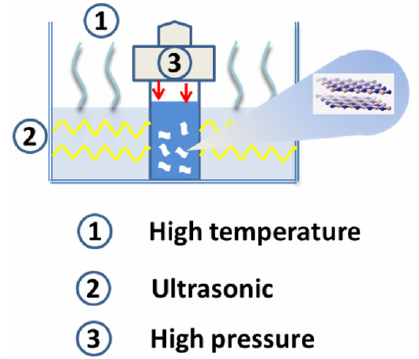
Fig. 1 Schematic of sonication-assisted hydrothermal